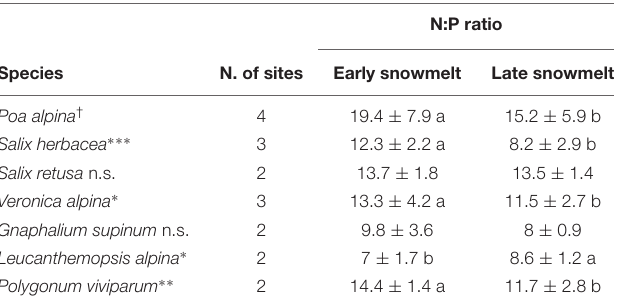
TABLE 2 | Mean ( ± SD) N:P ratio for the seven species investigated in the early and late snowmelt areas across the four study sites.